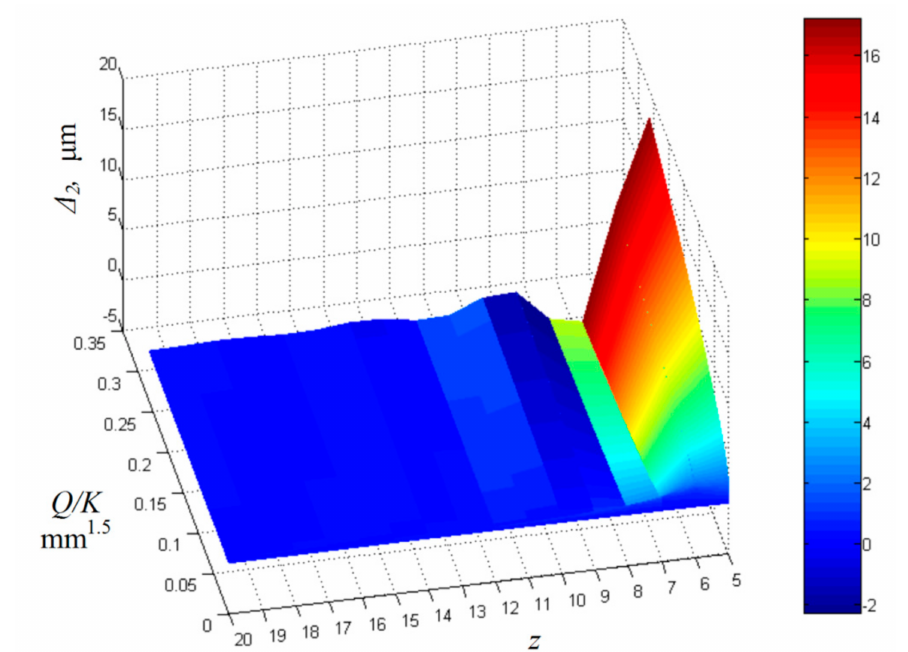
Figure 12. Three-dimensional dependence of vibration amplitude due to contact deformations ( ∆ 2 ) on the total number of rolling elements ( z ) and level of external load ( Q ).